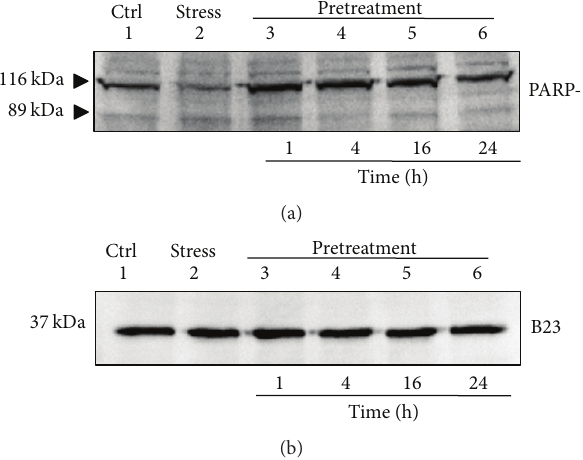
Figure 8: PARP-1 cleavage analysis. A western blot analysis of PARP-1 was performed using nuclear extracts. H9c2 cells were cultured under growth (lane 1) and stress conditions with 0.3 mM H 2 O 2 for 3 h (lane 2) or pretreated with TAT-Bcp1 (10 𝜇 M) for different times, 1h (lane 3) , 4 h (lane 4) , 16h (lane 5) , and 24 h (lane 6) , before oxidative stress was induced (a). B23 was used as the nuclear marker (b). Both the 116kDa full-length fragment and 89 kDa cleaved fragment are